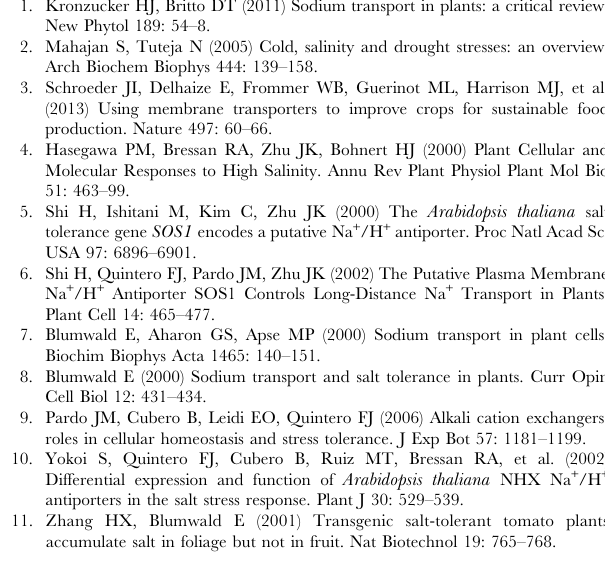
Figure S2 Prediction of transmembrane helices of VrNHX1 (AEO50758.1).The hydropathy plot was generated using TMPred online software. The positive values indicate putative transmem- brane domains as indicated as TM 1–11. Figure S3 Growth measurement of yeast strains under low pH. Yeast strains were grown in synthetic medium APGal (pH 4.0) and absorbance was measured at 600 nm. The data shown above are normalized to growth under normal condition (APGal, pH 7.0). W303-1B:- Wild type strain, AXTYES2.0:- AXT3 mutant harboring null pYES2.0 plasmid, AXTVrNHX1:- AXT3 mutant harboring pYES VrNHX1 recombinant plasmid. Data represent mean from three independent events (n= 3) and standard error plotted in the graph. Statistically significant values at P # 0.05 are indicated as ‘‘*’’, using Bonferroni analysis. Figure S4 Calibration curve for pH sensitive BCECF fluores- cent dye was plotted using standards ranging from pH 4.0–8.0. Yeast strains (W303-1B, AXTYES2.0, AXTVrNHX1) grown in